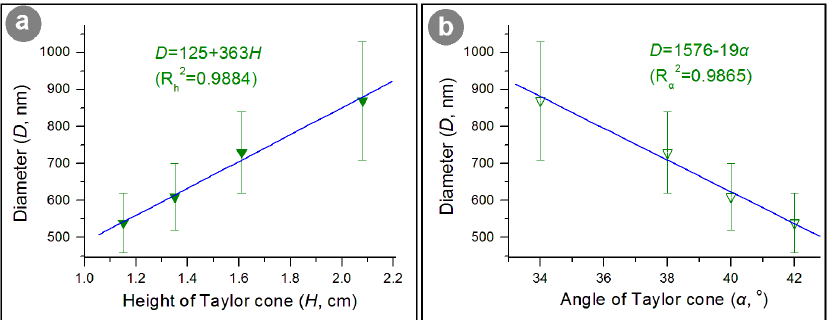
Figure 7. The interrelations between the nanofibers and the Taylor cone: ( a ) The relationships between the height of the Taylor cone and the nanofibers’ diameter; ( b ) The relationships between the angle of the Taylor cone and the nanofibers’ diameter.